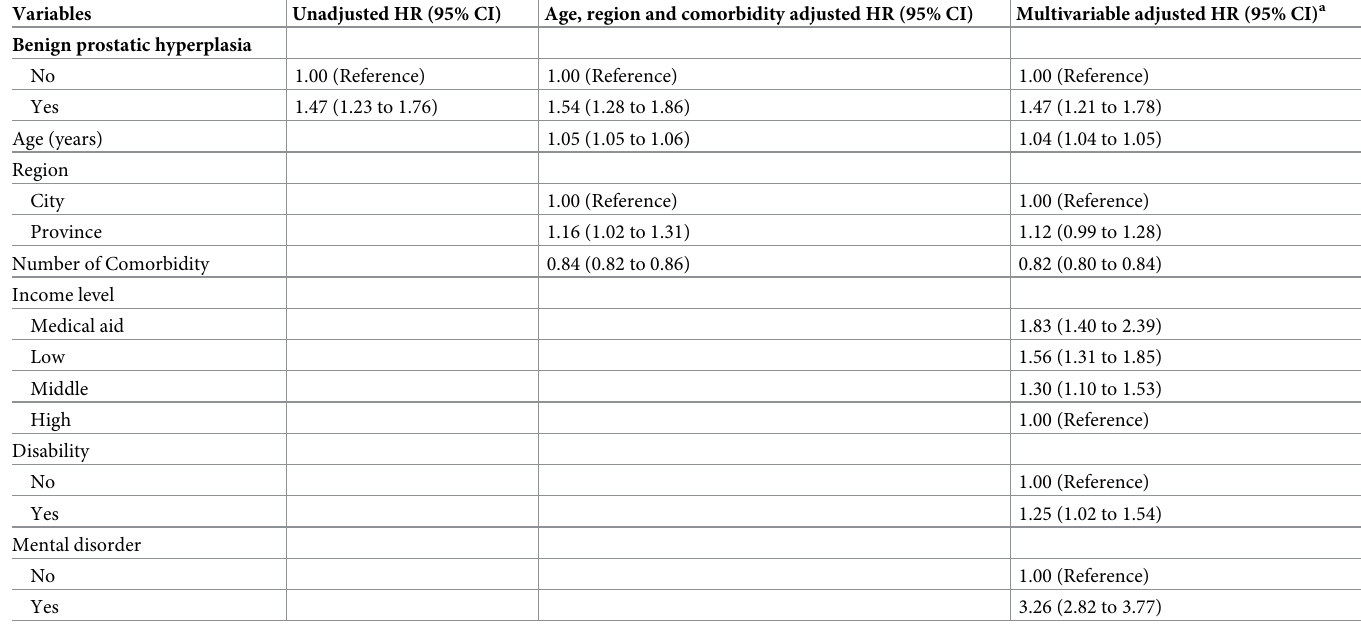
Table 3. Hazard ratios (95% CI) for suicide among patients with benign prostatic hyperplasia compared to general population without benign prostatic